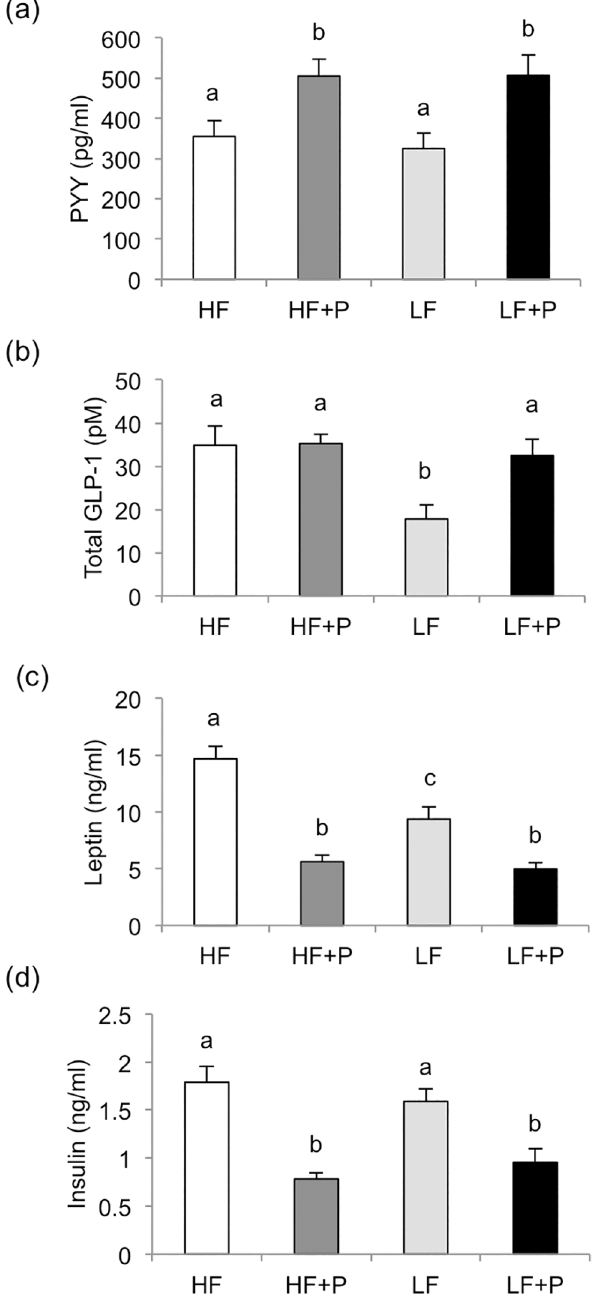
Fig 3. Plasma hormones. Final plasma concentrations of (a) PYY, (b) total GLP-1, (c) leptin, and (d) insulin in diet induced obese rats fed high fat diet (HF), high fat diet with 10% w/w pectin (HF+P), low fat diet (LF), or low fat diet with 10% w/w pectin (LF+P) for 4 weeks in two independently replicated experiments ( n = 16 per diet group). Within figures, values labelled with different letters are significantly different ( P < 0.001).